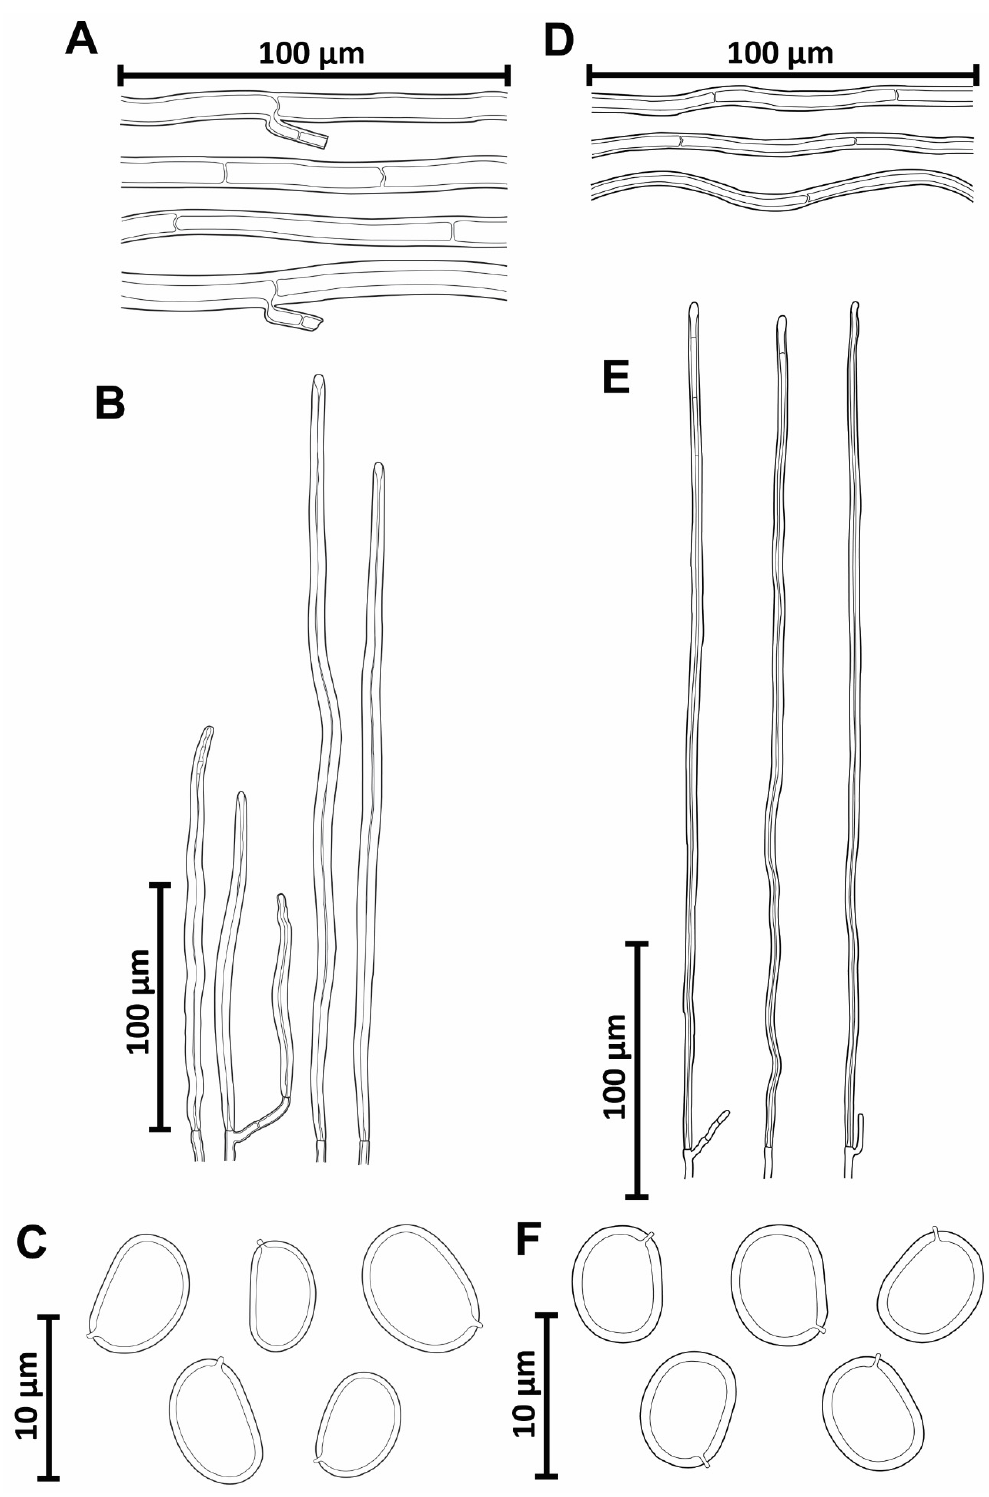
Figure 10. Micromorphological features of Phellinotus scaber and P . xerophyticus . ( A – C ) Phellinotus scaber . ( A ) Generative hyphae of the context; ( B ) skeletal hyphae of the tubes; ( C ) basidiospores. ( D – F ) Phellinotus xerophyticus . ( D ) Generative hyphae of the context; ( E ) skeletal hyphae of the tubes; ( F )